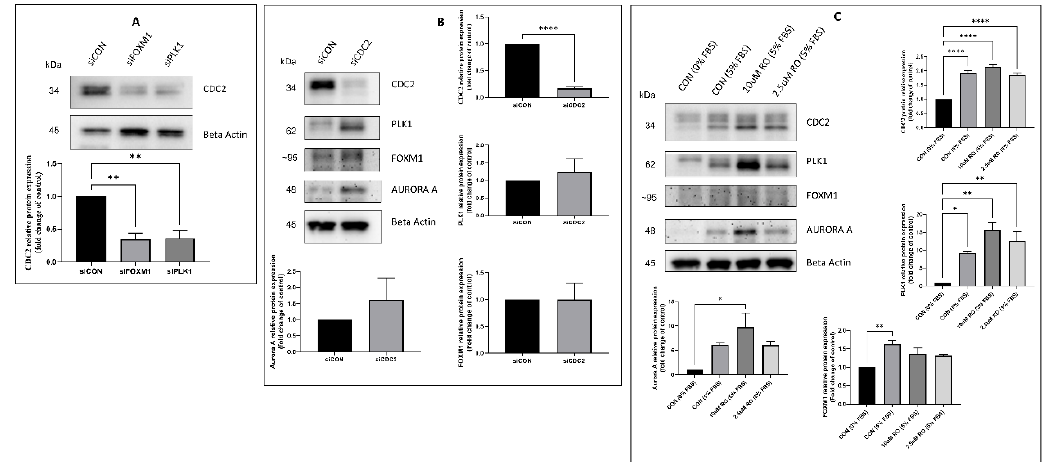
Figure 3. Effectors of CDC2 expression in PAH HPASMC. ( A ) Western blot showing the effect of FOXM1 and PLK1 knockdown on the expression of CDC2 in PAH HPASMC. ( B ) Western blot showing the effect of CDC2 knockdown on the expression of PLK1, FOXM1, Aurora A, and beta actin in PAH HPASMC. ( C ) Western blot showing the effect of CDC2 inhibitor (RO-3306) on the expression of PLK1, FOXM1, Aurora A, and beta actin in PAH HPASMC. Images are representative of at least triplicate experiments. Bar graphs indicate group means for these experiments, and the error bars represent the standard deviation. *- p < 0.05, **- p < 0.01 and ****- p < 0.0001.